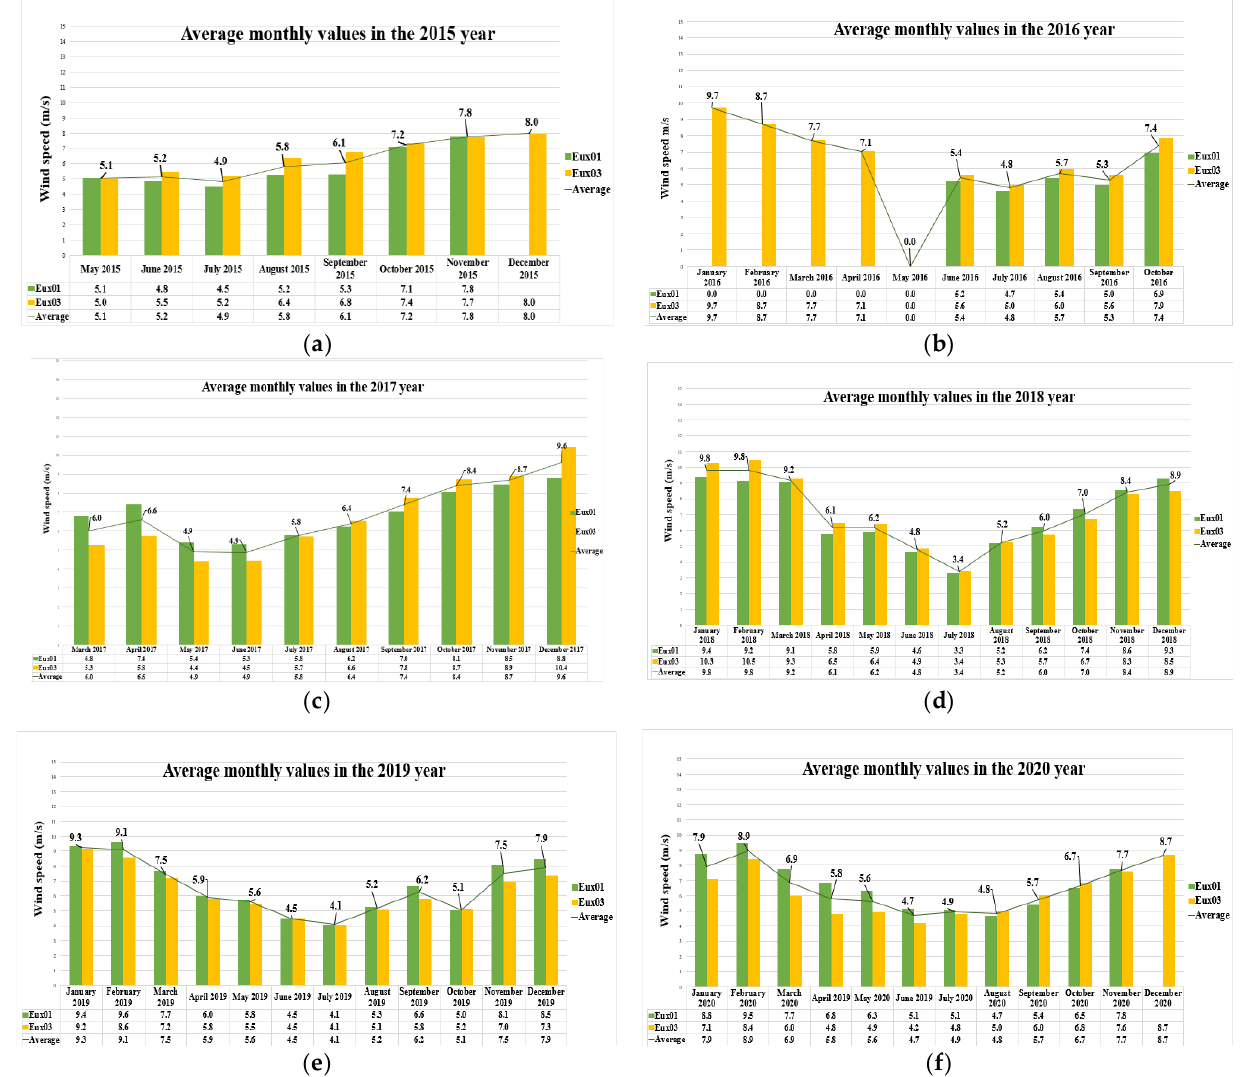
Figure 5. Annual evaluation of the wind data; ( a ) 2015; ( b ) 2016; ( c ) 2017; ( d ) 2018; ( e ) 2019; ( f ) 2020.